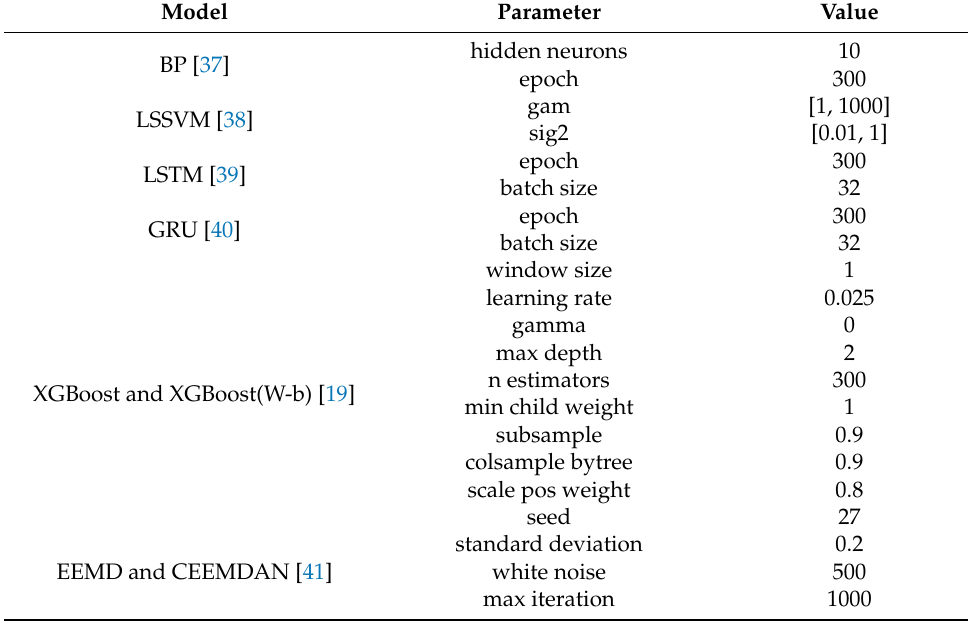
Table 3. Parameter setting of the models.